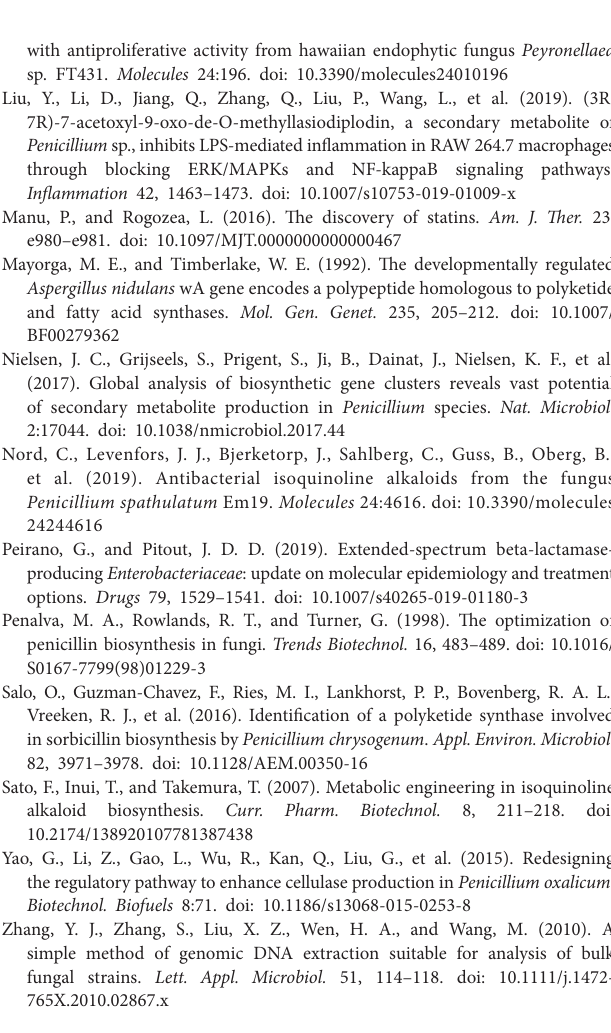
Supplementary Figure S1 | Phylogenetic tree analysis of P2648 and related filamentous fungi. Phylogenetic tree of P2648 and all related strains were reconstructed based on a 18S RNA gene alignment using the MEGA X software package with the neighbor-joining method. Bootstrap analysis (1,000 replications) was used to provide confidence estimates for phylogenetic tree topologies, and the percentage values are indicated at nodes. Supplementary Table S1 | Protein-encoding gene